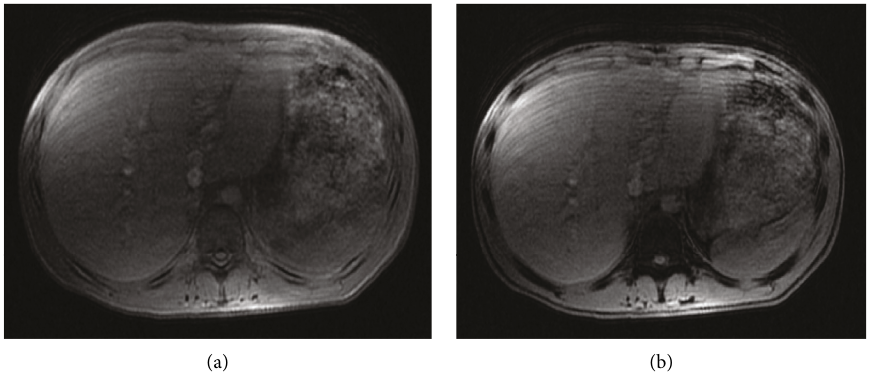
Figure 2: T1-MRI images showing no difference in the signal intensities between the in-phase (a) and opposed-phase (b).